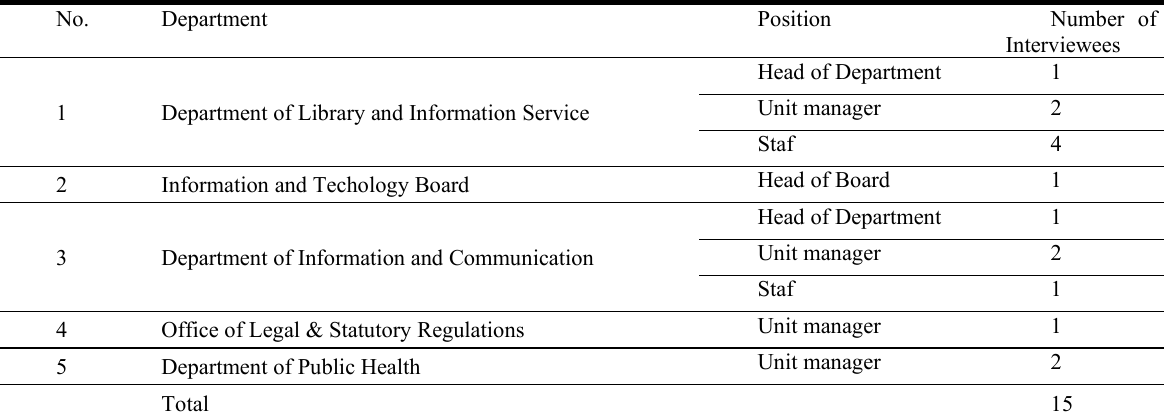
Table 1: Composition of the Interviewees No.